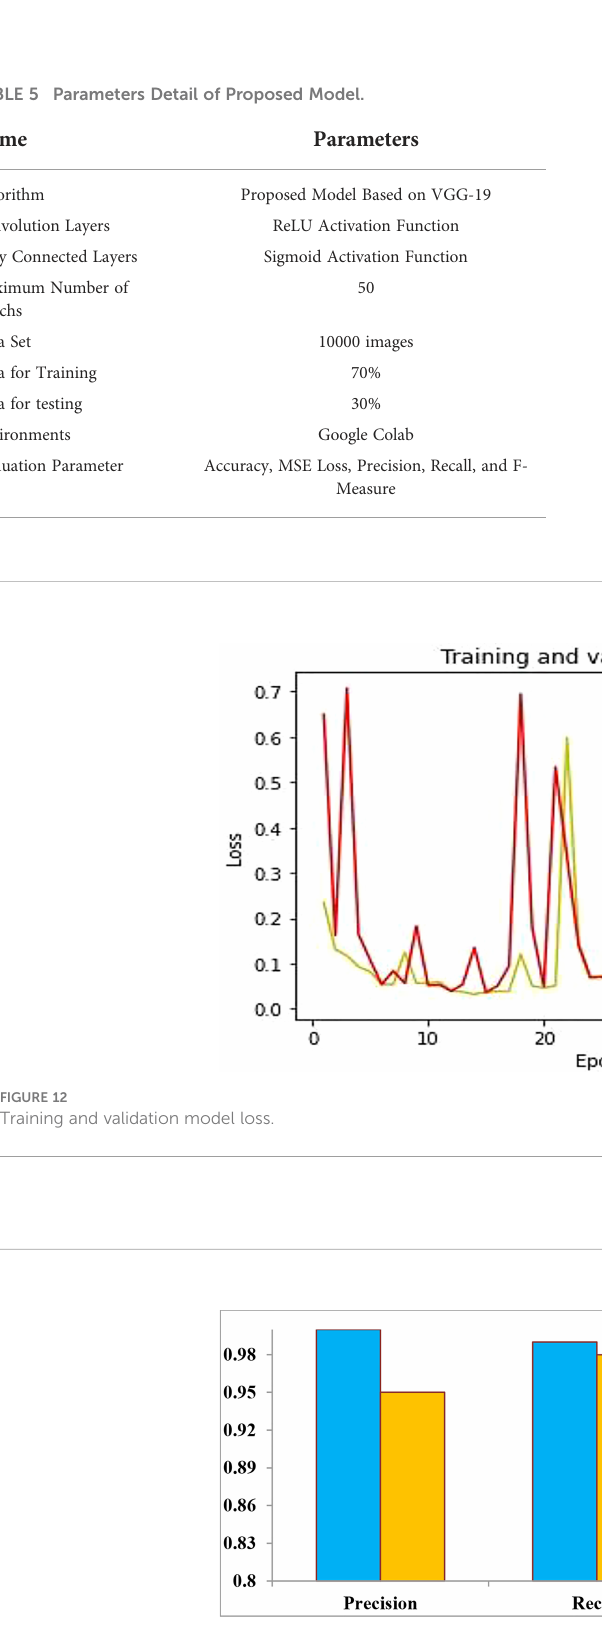
FIGURE 13 Performance parameter of the LWNet